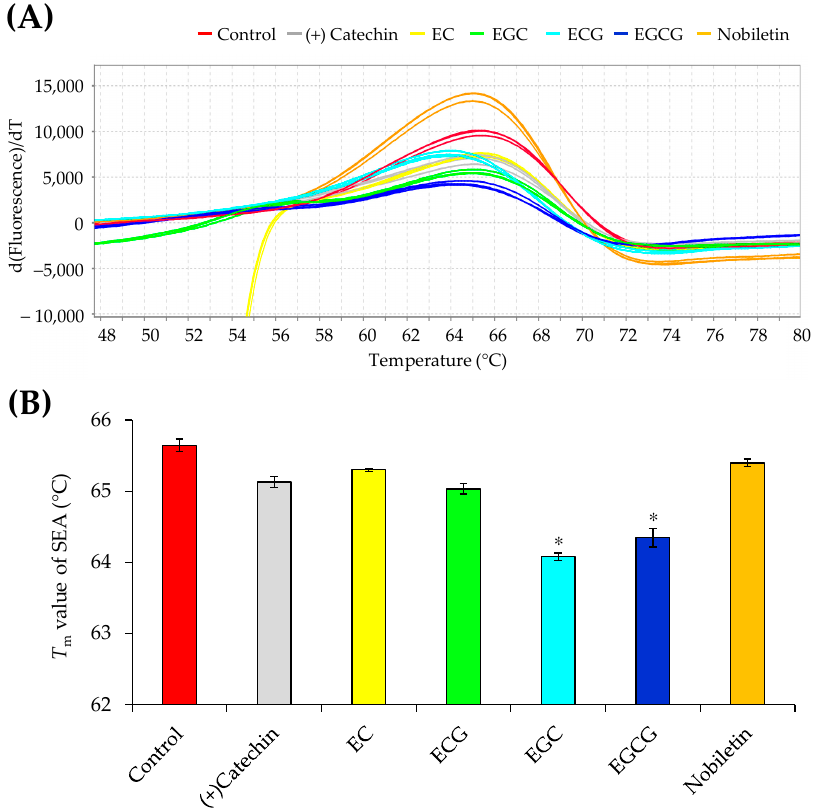
Figure 2. Interactions between SEA and polyphenols. ( A ) Melting profile of SEA in the presence of polyphenols. The images show the profile of the derivative of fluorescence emission as a function